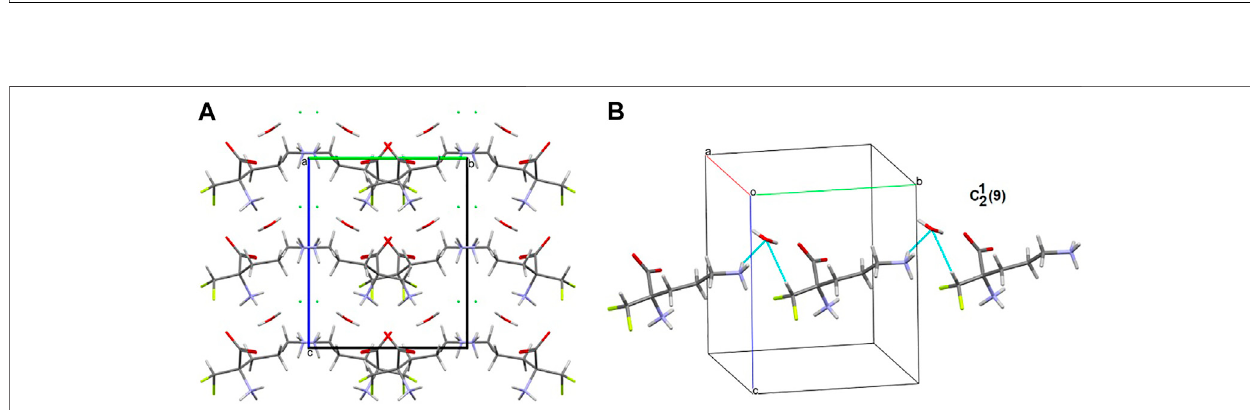
FIGURE 8 | Supramolecular synthon linking DFMO and H 2 O moieties in the crystal structure of 1 .